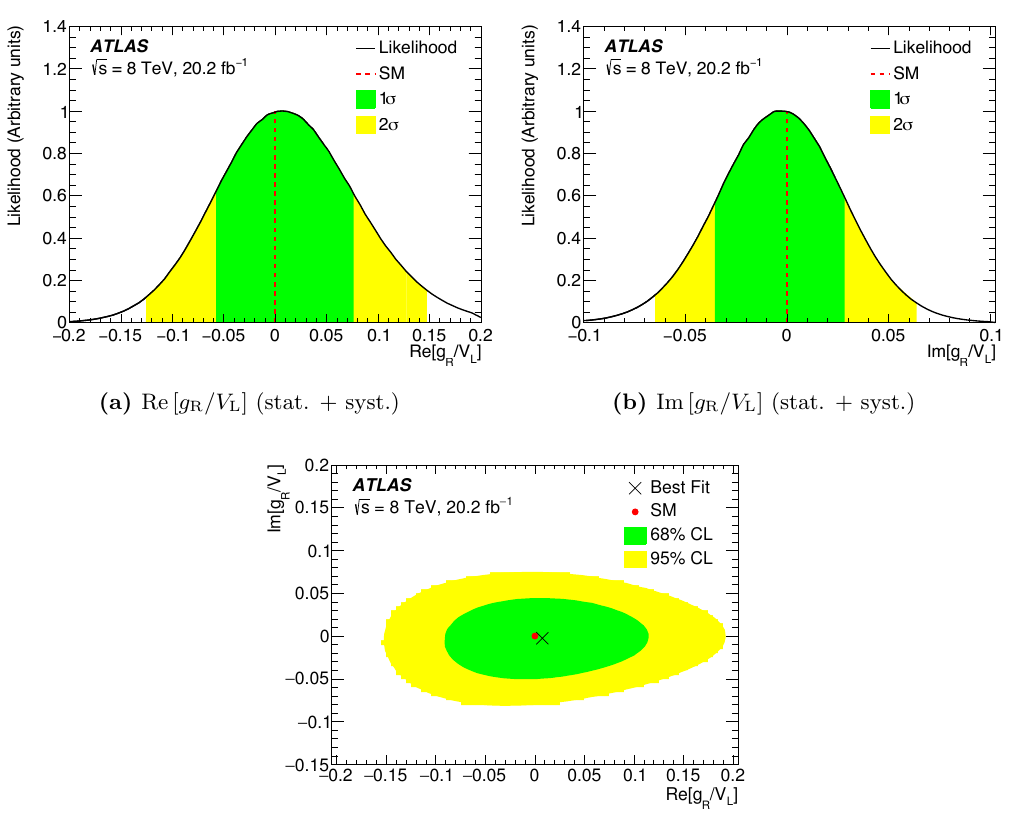
Figure 13. The likelihood pro(cid:12)les for the parameters (a) Re [ g R =V L ] and (b) Im [ g R =V L ] are shown. The black line indicates the evaluated likelihood in each bin of the pro(cid:12)led variable. The red dashed line represents the SM expectation. Additionally (c), the joint likelihood contour of Im [ g R =V L ] as a function of Re [ g R =V L ] is shown. The red point represents the SM expectation while a black x mark indicates the observed value. The 68% and 95% CL regions are shown in green and yellow,